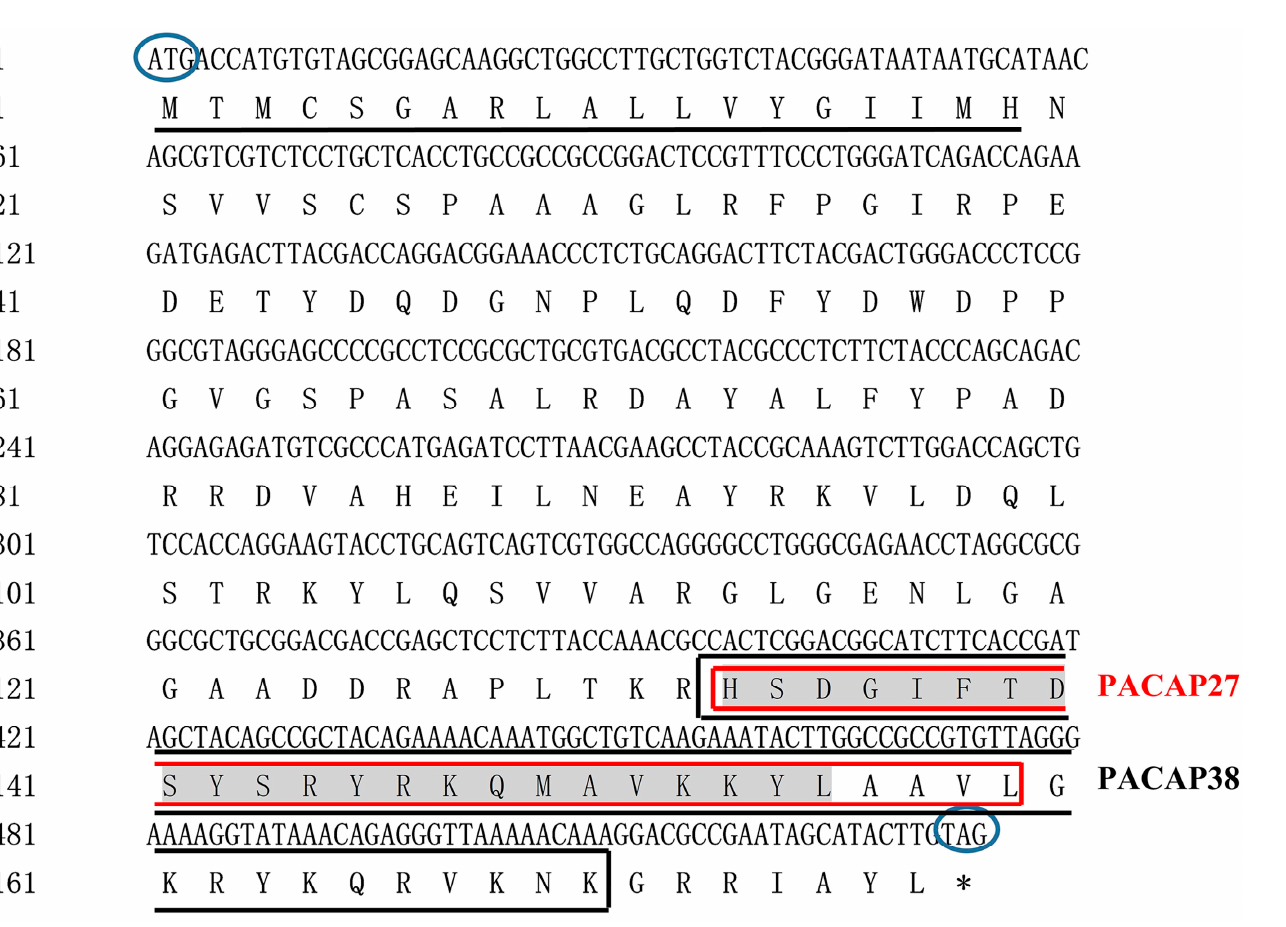
Figure 2. Nucleotide sequence and the derived amino acid sequence of the coding region of PACAP : The number of nucleotides and derived amino acid residues are shown on the left. The two polypeptides PACAP27 and PACAP38 are represented by the box. Oval indicates the start and stop codons. Underlined are the signal peptides and shading represents the glucagon/GIP/secretagogue/VIP family marker. * indicates that the stop codon (TGA) does not encode amino acids.